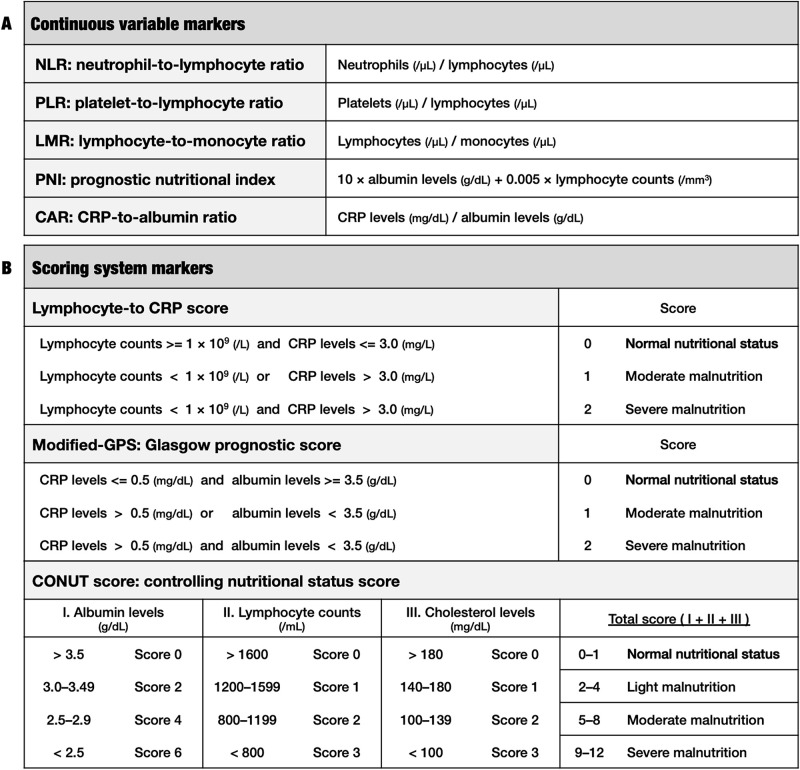
Definitions of inflammatory / immunonutritional markers.(A) Continuous variable markers. (B) Scoring system markers. Normal nutritional status of patients corresponds to low score as follows: score 0 in lymphocyte-to-CRP score and modified-GPS, and score 0 to 1 in CONUT score. Abbreviations: CRP: C-reactive protein.